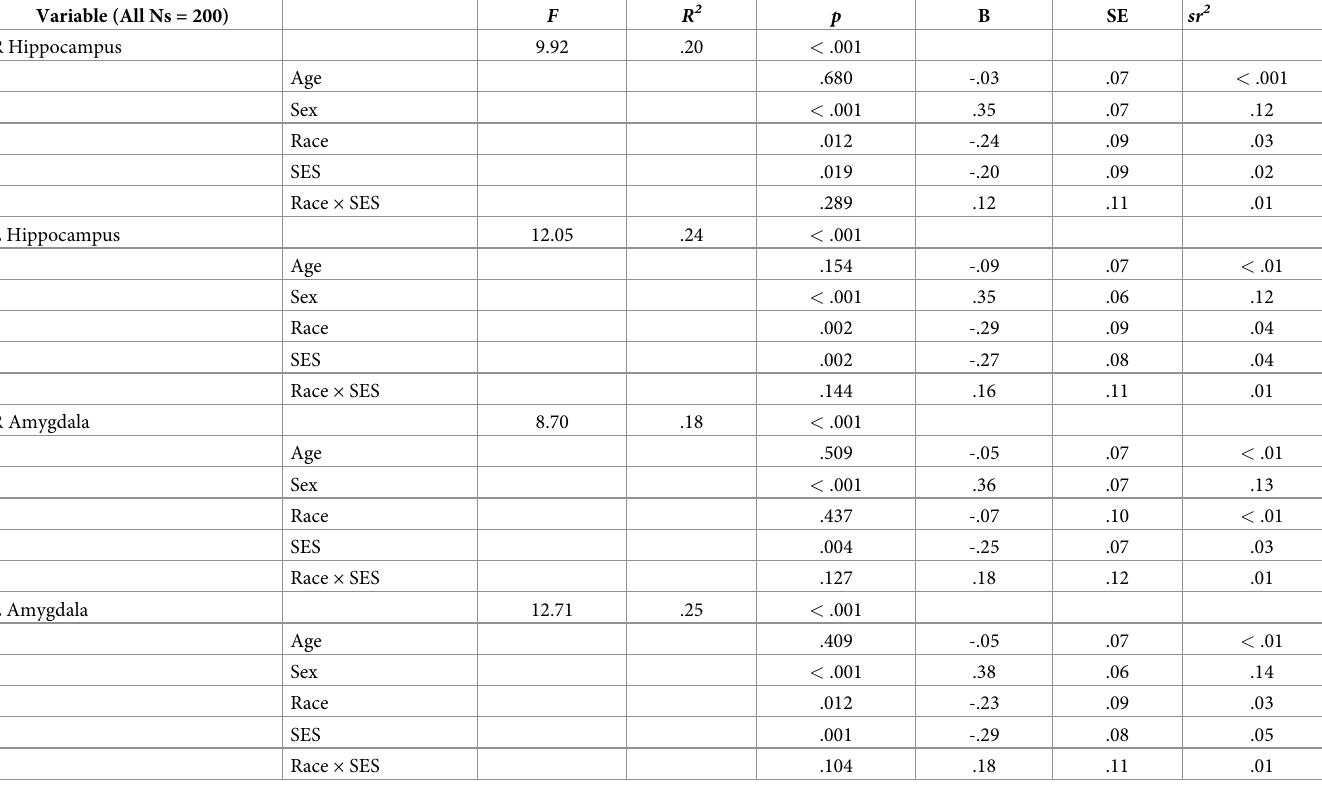
Table 2. Multiple regression analyses: Interaction of SES and race on subcortical gray matter volumes. Variable (All Ns = 200)